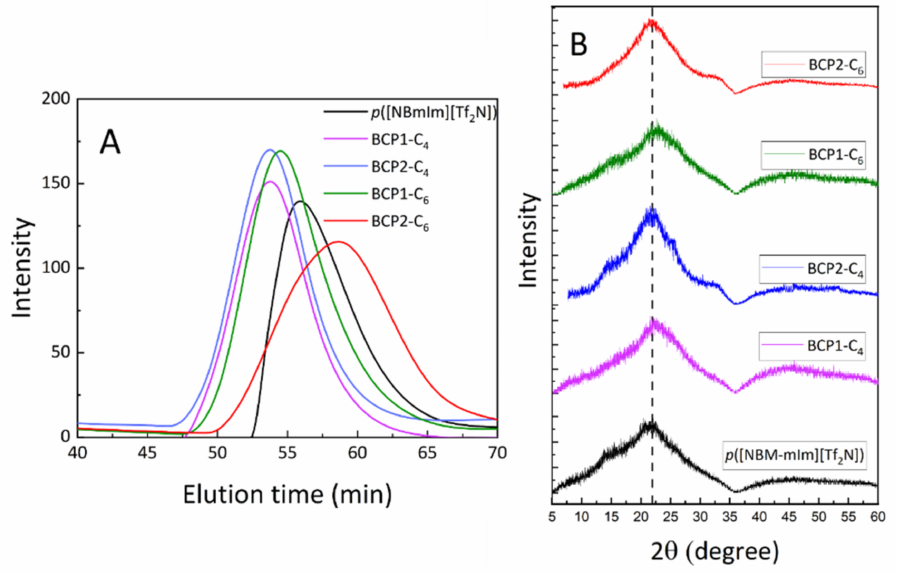
Figure 3. Gel permeation chromatograph ( A ) and wide-angle X-ray diffraction ( B ) plots for the p ([NBM-mIm][Tf 2 N]) and BCPs membranes. Table 1. Details of abbreviation, structural, and molecular weight for p ([NBM-mIm][Tf 2 N) and